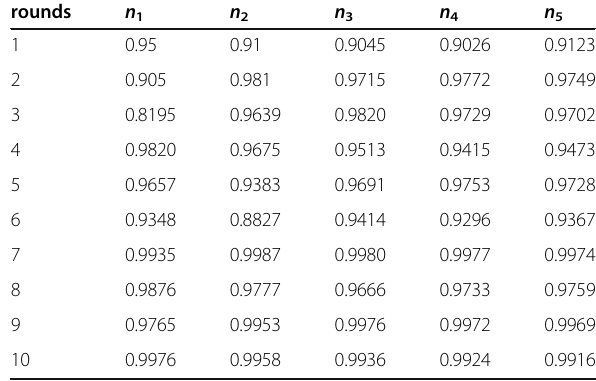
Table 8 Trust value of sink after 10 rounds of data transmission rounds